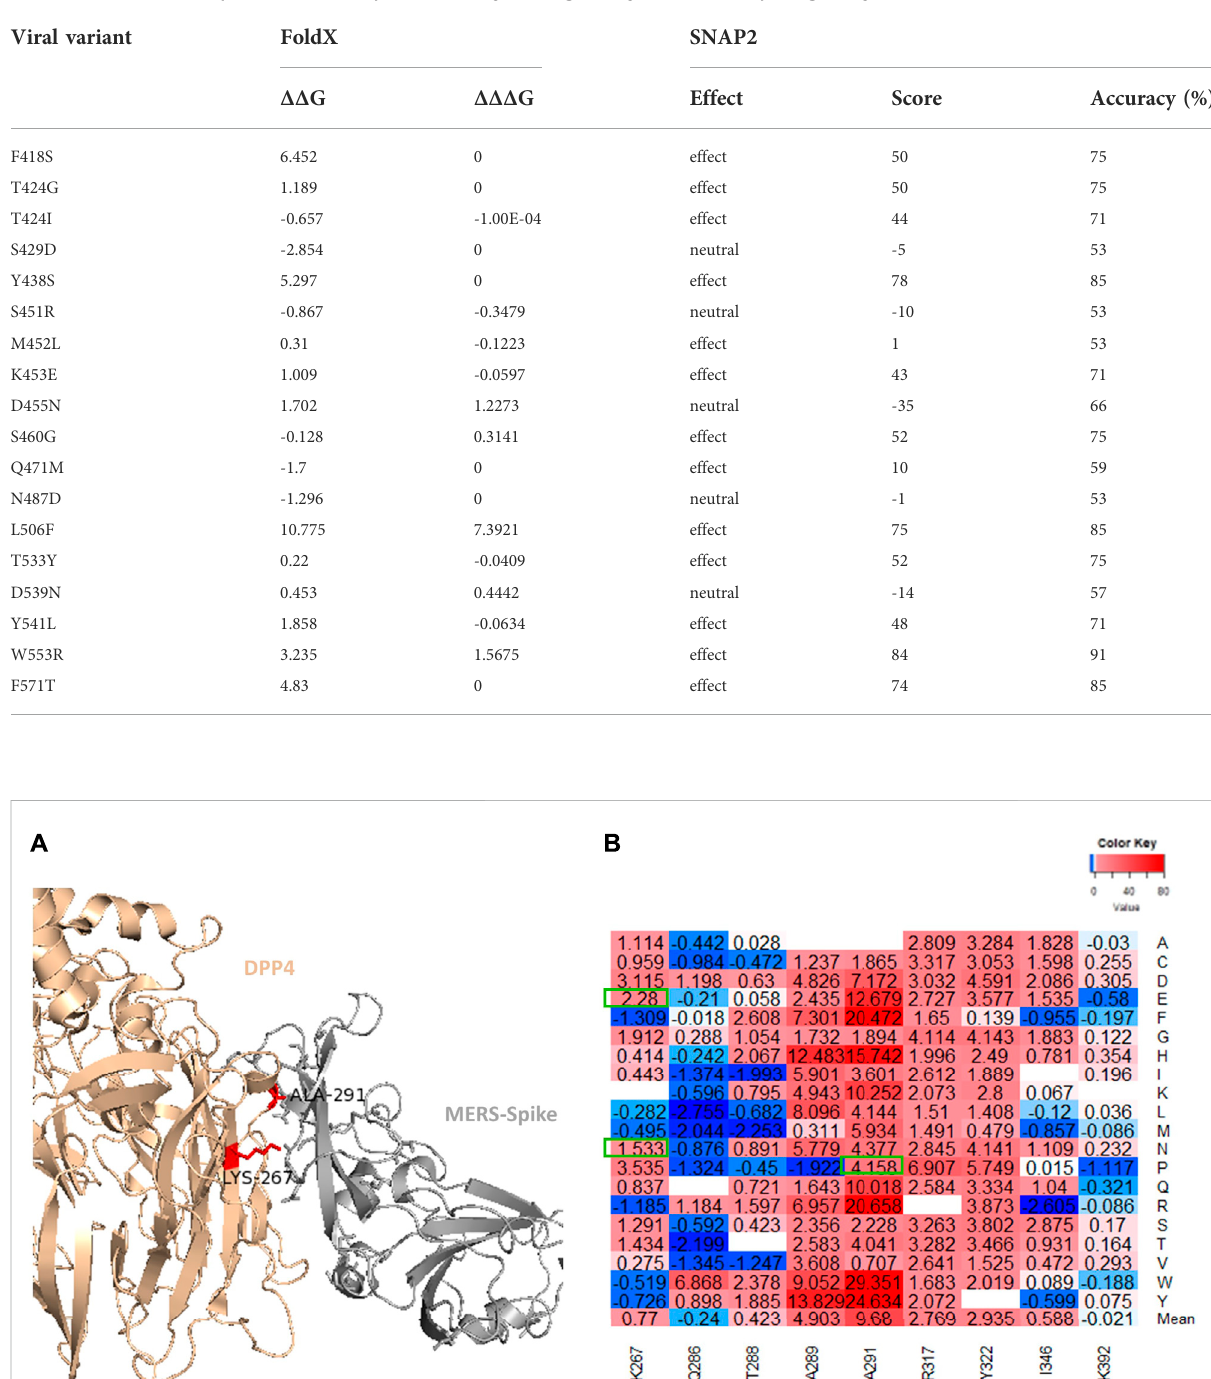
TABLE 1 The effects of top viral variants on protein stability, binding af fi nity and mutation pathogenicity.